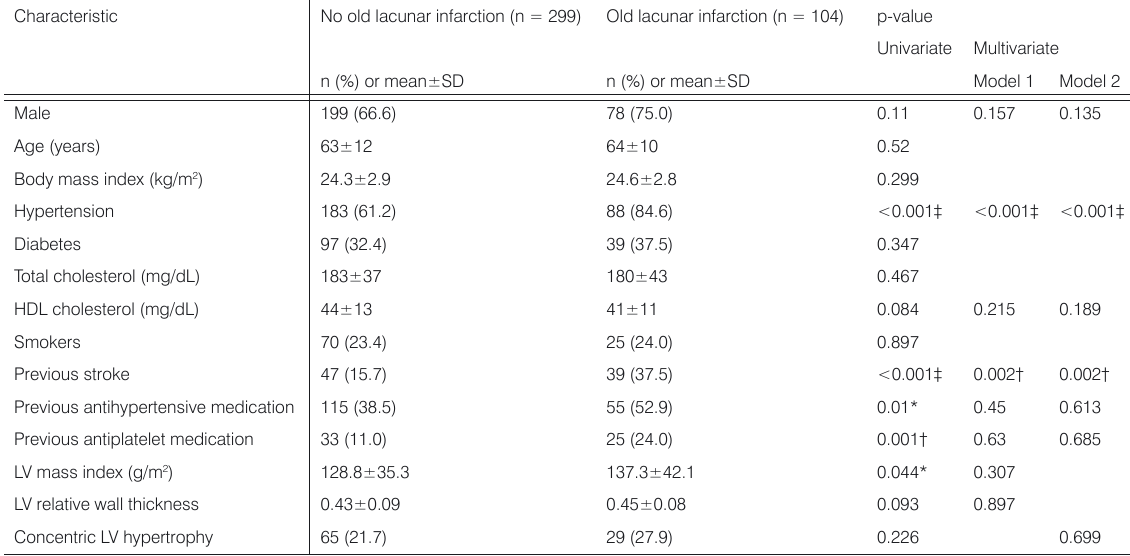
Table 5. Clinical characteristics of 403 patients according to the presence of old lacunar infarction.